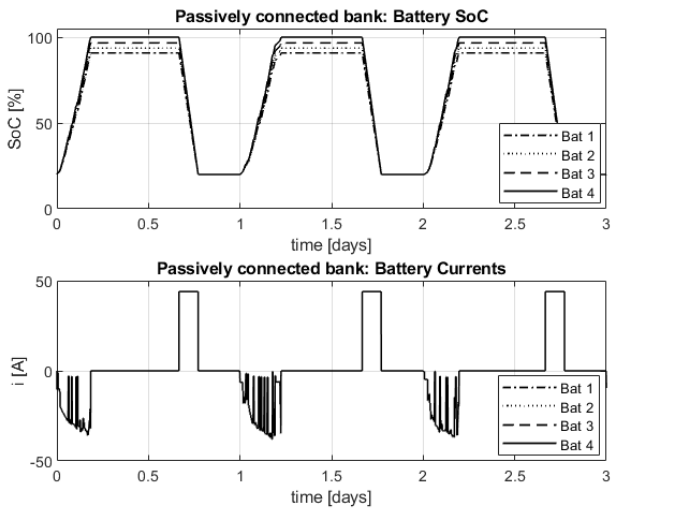
Figure 12. Electrical currents and SoC (passively connected lithium battery